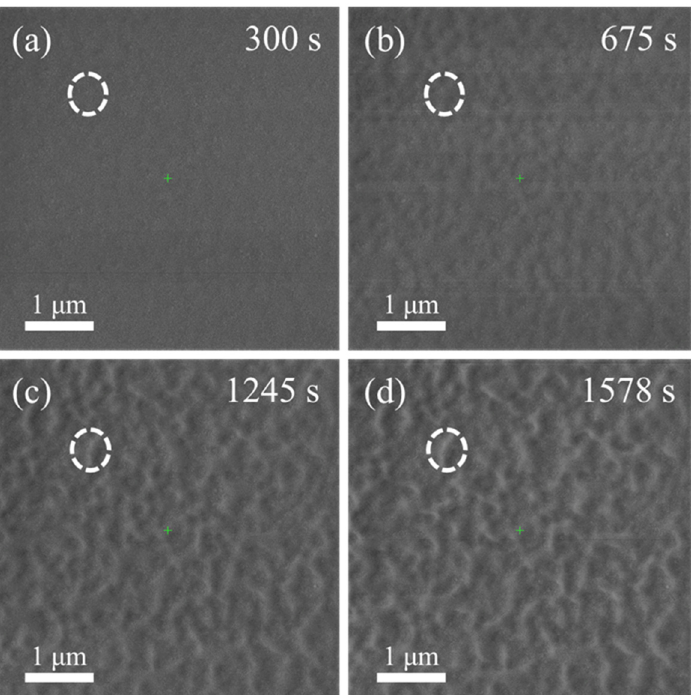
Figure 3. Morphological evolution of N–A TiAl fi lm during helium ions implantation with a maxi- mum dose of 4 × 10 17 ions cm − 2 of 20 keV helium ions: ( a ) 300 s; ( b ) 675 s; ( c ) 1245 s; and ( d ) 1578 s. Note that 300 s corresponds to a helium ions fl uence of 0.76 × 10 17 ions cm − 2 , 675 s to 1.71 × 10 17 ions cm − 2 , 1245 s to 3.15 × 10 17 ions cm − 2 , and 400 s to 4 × 10 17 ions cm − 2 .